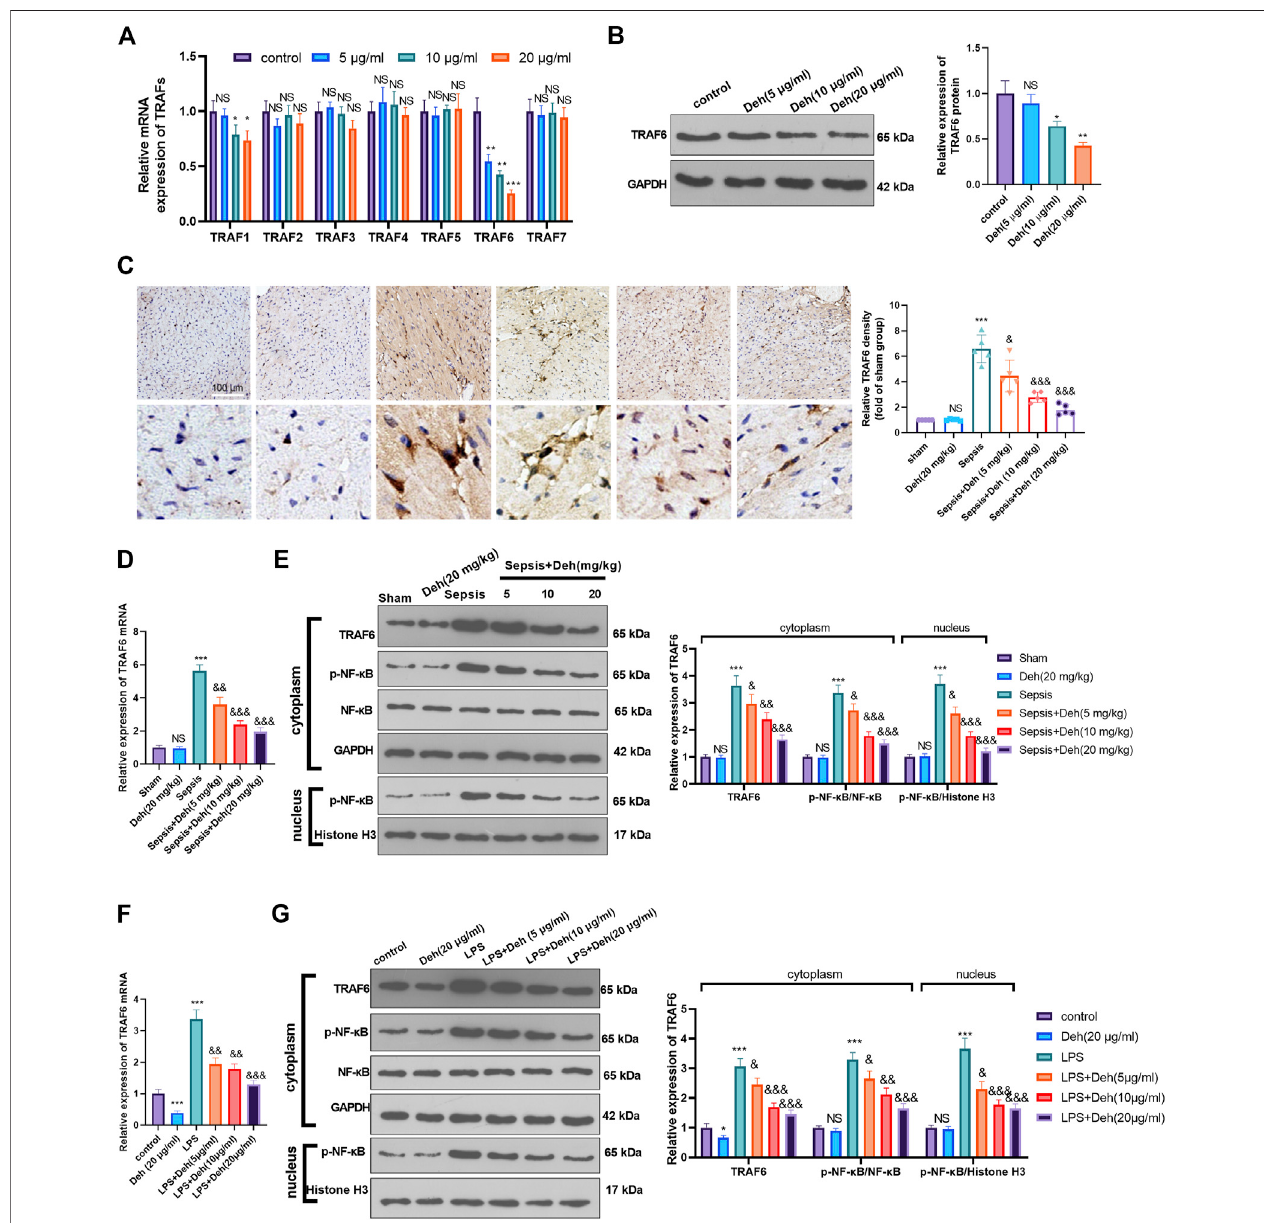
FIGURE 4 | Deh attenuated TRAF6/NF- κ B expression. (A) RT-PCR was used for evaluating TRAF1 ∼ 7 in H9C2 cells treated with Deh (5 – 20 μ g/ml) for 24 h. (B) WesternblotwasperformedtoexamineTRAF6inH9C2cells. (C) ImmunohistochemistrywasusedtoevaluatetheexpressionofTRAF6inthemousemyocardialtissues of each group, N (cid:1) 5. (D, E) RT-PCR and Western blot was used for evaluating TRAF6 and p-NF- κ B expressions in the myocardial tissues of each group, N (cid:1) 5. (F, G) RT-PCR and Western blot was used for evaluating TRAF6 and p-NF- κ B expressions in H9C2 cardiomyocytes, N (cid:1) 3. NS p > 0.05, * p < 0.05, ** p < 0.01, *** p < 0.001 (vs. control or sham group); & p < 0.05, && p < 0.01, &&& p < 0.001 (vs. LPS